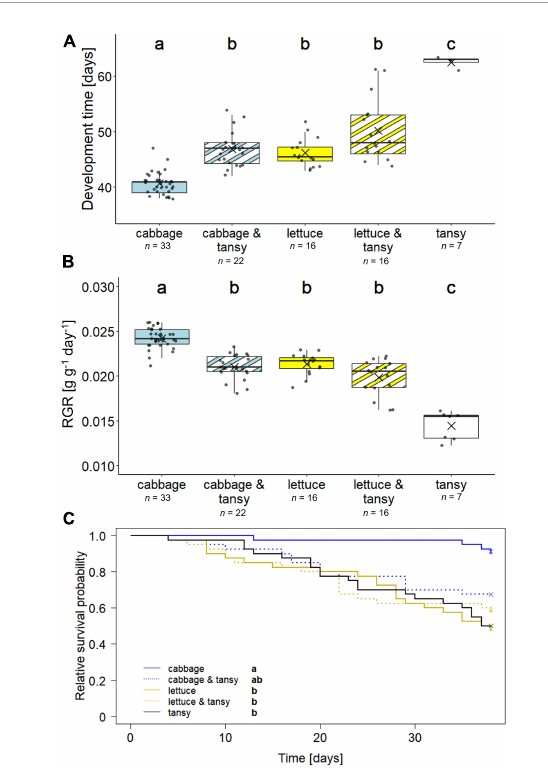
FIGURE1 Development and survival of Galeruca tanaceti on different diets with the (A) development time from larval hatch until adulthood, (B) relative growth rate (RGR), and (C) survival probability until day 38 [initially n = 40 per dietary treatment; n = 7–33 per dietary treatment in panels (A,B) as indicated below the x-axis, because the parameters could only be calculated for individuals that reached adulthood]. Individuals were either reared on mono diets of cabbage ( Brassica rapa ), lettuce ( Lactuca sativa ), or tansy ( Tanacetum vulgare ) or received mixed diets (host plant change every other day) of cabbage and tansy or lettuce and tansy. Box plots (A,B) show the means (as crosses), medians (horizontal lines), and the interquartile ranges (IQR; boxes), the whiskers extend to the most extreme values with max. 1.5 times the IQR. Individual values are plotted as dark circles. Survival (C) is depicted as Kaplan–Meier curves, including data until day 38 when the first individual reached adulthood; crosses at day 38 indicate right censoring (i.e., individuals were still alive at this time point). Statistical analyses were done with Kruskal–Wallis tests followed by pairwise Mann–Whitney U -tests (A,B) and an overall log-rank test followed by pairwise log-rank tests (C) , respectively. Significant differences ( p < 0.05) are indicated by different lowercase letters.